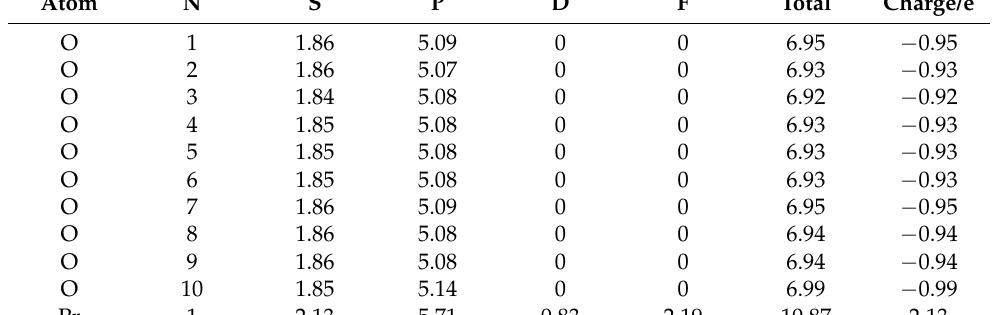
Table 2. The Mulliken charge population of Pr and O in [Pr(H 2 O) 10 ] 3+